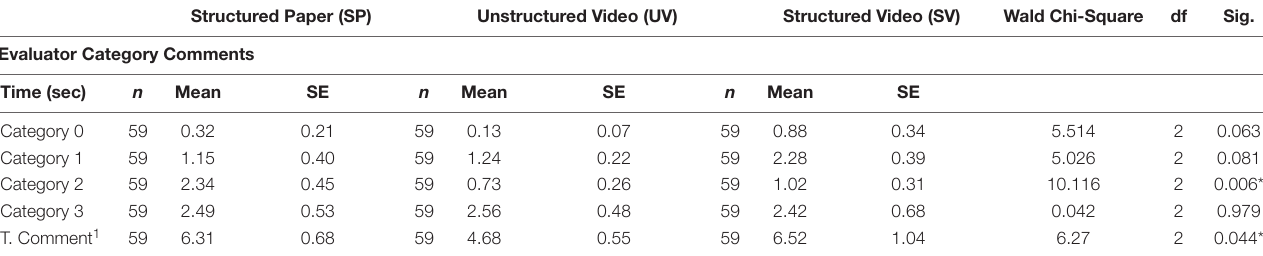
TABLE 5 | Estimated marginal means and standard error of evaluator and performer quality feedback and significance by peer evaluation condition. Structured Paper (SP) Unstructured Video (UV)